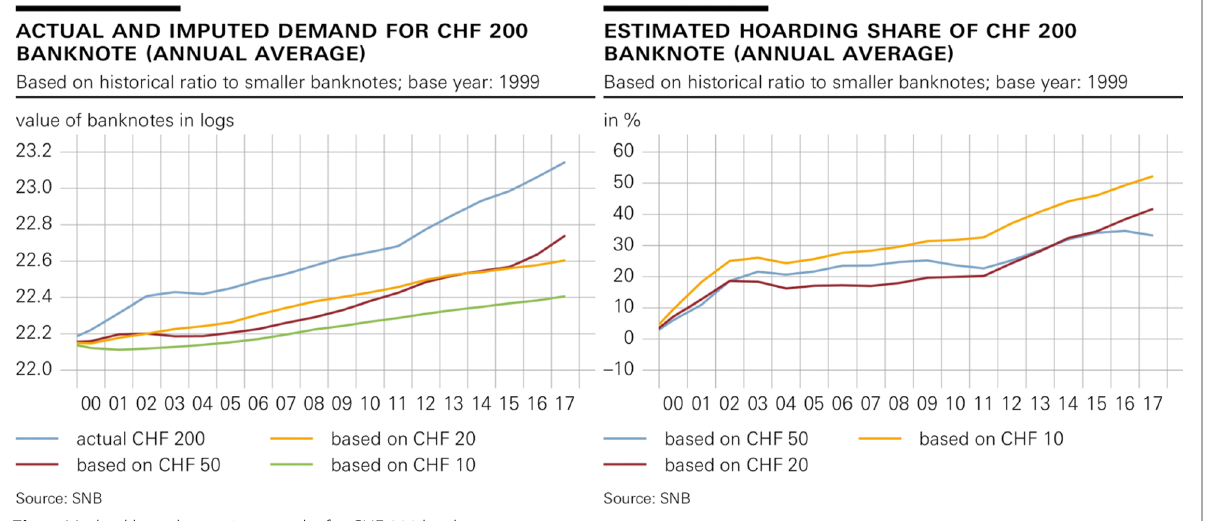
Fig. 5 Method based on ratios - results for CHF 200 banknote